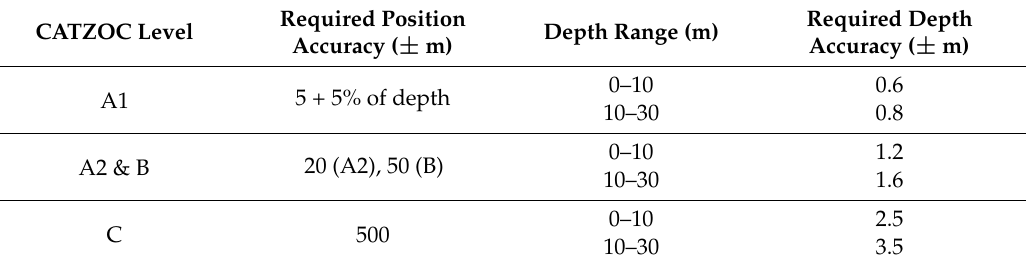
Table 6. Required depth accuracies for International Hydrographic Organization (IHO) CATegory of Zones Of Confidence (CATZOC) levels